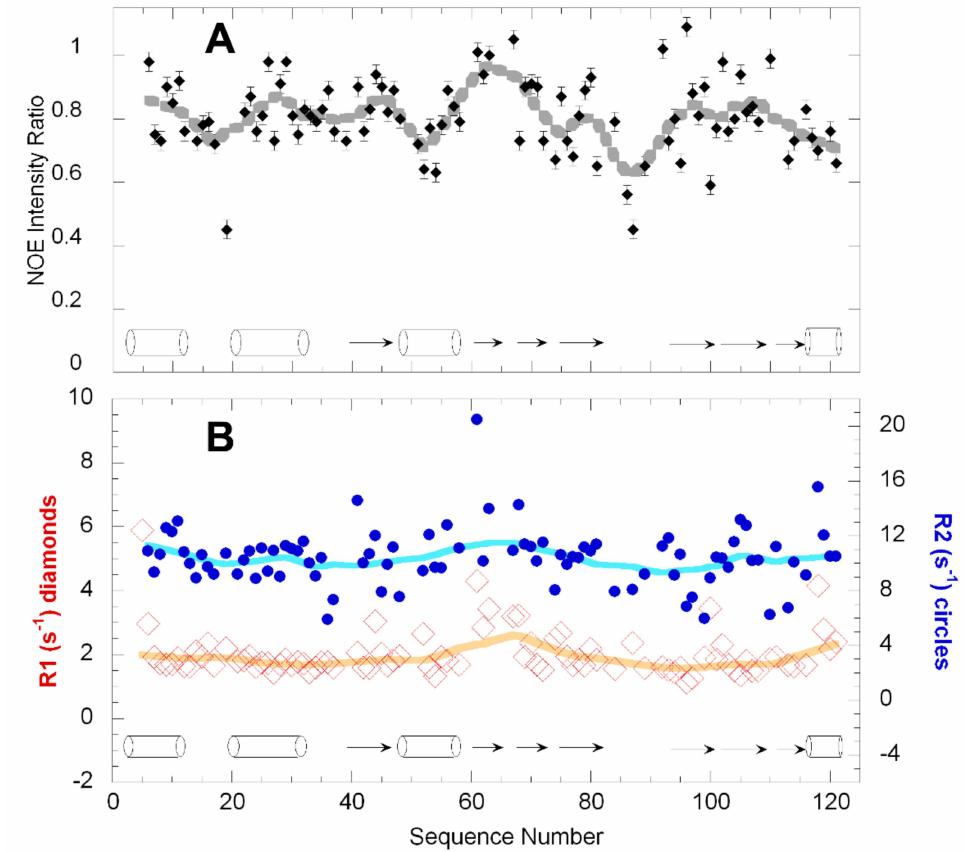
Figure 3. The secondary structure (from the X-ray crystal structure PDB 1ANG) is represented by cylinders for helices and arrows for β -strands. The thick lines represent the weighted average over the nearest measured values along the sequence. ( A ) Fast timescale dynamics assessed by the { 1 H}- 15 N NOE. ( B ) µ s-ms timescale dynamics gauged by R 1 (red open diamonds, left y -axis) and R 2 (blue circles, right y -axis) relaxation